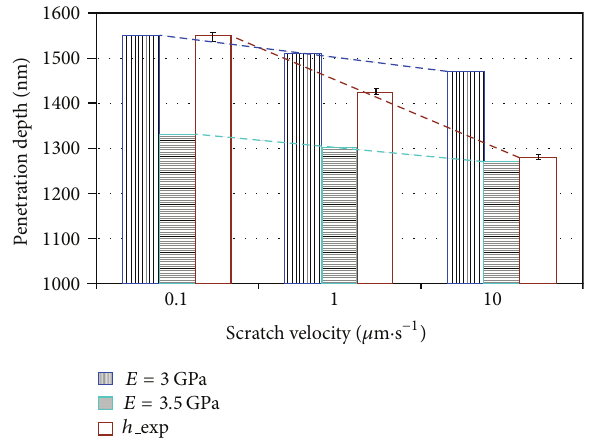
Figure 7: Comparison of experimental results ( ℎ exp) and numer- ical results for 𝐹 𝑛 = 40 mN. The data denoted by 𝐸 = 3.0 GPa (resp., 𝐸 = 3.5 GPa) are those calculated with the elastic-viscoplastic model in using a Young modulus of 3.0 GPa (resp., 3.5 GPa).